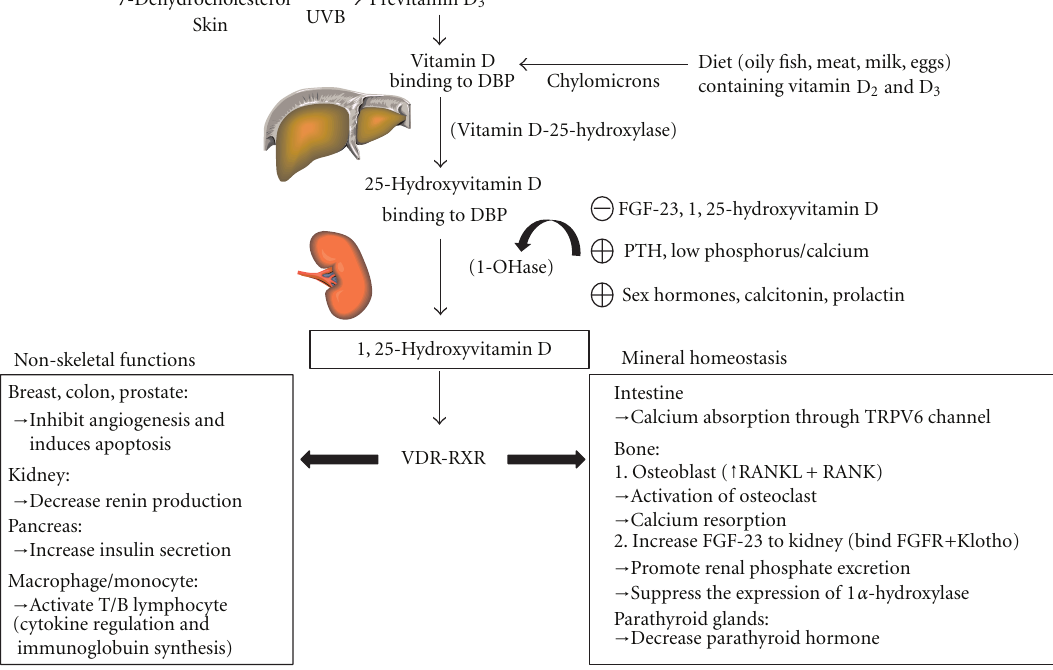
Figure 1: The synthesis and metabolism of vitamin D in the regulation of mineral homeostasis and nonskeletal functions. When under exposed to solar UVB (ultraviolet B), 7-dehydrocholesterol in the skin is converted to previtamin D 3 , which is immediately converted to vitamin D 3 . Vitamin D can also be obtained from dietary vitamin D 2 and D 3 incorporated into chylomicrons. Vitamin D in the circulation is bound to DBP (vitamin D-binding protein), which transports it to the liver where it is converted to 25-hydroxyvitamin D by vitamin D-25-hydroxylase. The biologically inactive 25-hydroxyvitamin D must be converted in the kidneys to active 1,25-hydroxyvitamin D by 1-OHase (25-hydroxyvitamin D 3 1 α -hydroxylase). Serum PTH (parathyroid hormone), low phosphorus/calcium, sex hormones, calcitonin, and prolactin can increase ( ⊕ ) the renal production of 1,25-hydroxyvitamin D. However, FGF-23 (fibroblast growth factor 23) and 1,25- hydroxyvitamin D have feedback functions to inhibit ( (cid:2) ) 1-OHase. Finally, the active 1,25-hydroxyvitamin D can bind to VDR-RXR (vitamin D receptor-retinoic acid x-receptor complex) in the intestine, bone, and parathyroid glands and then exert the classical function of mineral homeostasis. In addition, it also has nonskeletal functions when bound to VDR-RXR in other organs (breast, colon, prostate, kidney, pancreas) or immune cells (macrophages/monocytes). FGFR: FGF-23 receptor; TRPV6: transient receptor potential cation channel, subfamily V, member 6; RANKL: receptor activator of nuclear factor- κ B ligand; RANK: the receptor for RANKL on